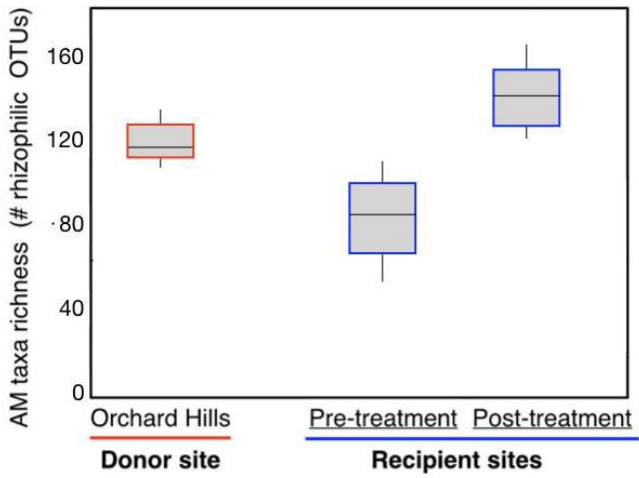
Figure 9. Richness of rhizophilic AMF taxa. “Donor site” refers to OTU (operational taxonomic unit, equivalent to molecular species concept) richness found at the donor site, while “Recipient sites” refers to all other sampling locations at the recipient sites. Rhizophilic AMF richness was measured in the donor site and the recipient site, “pre-treatment”, in December 2015 and recipient sites, “post-treatment” were measured in April 2017. Rhizophilic AMF richness was significantly higher in recipient sites, post-treatment, in 2017, than in the recipient sites, pre-treatment, in 2015 ( p <